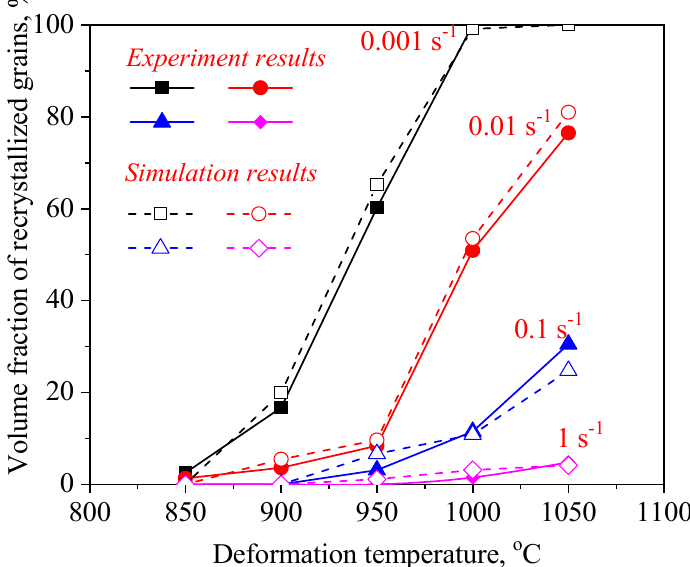
Figure 12. A comparison between the experimental and FE simulation results of the volume fraction of DRX ( X DRX ).